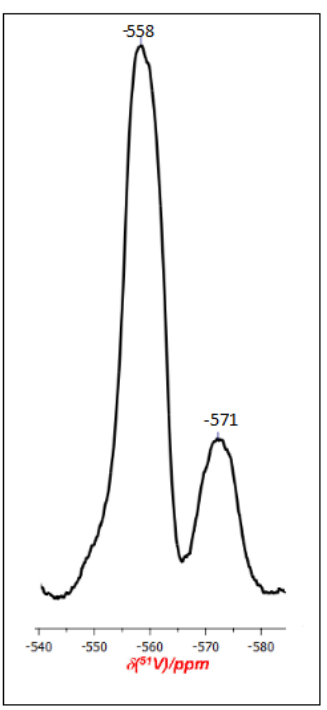
Figure 6. Vanadium-51 Nuclear Magnetic Resonace spectrum of Compound 1 in phosphate-buffered saline (PBS)/D 2 O.